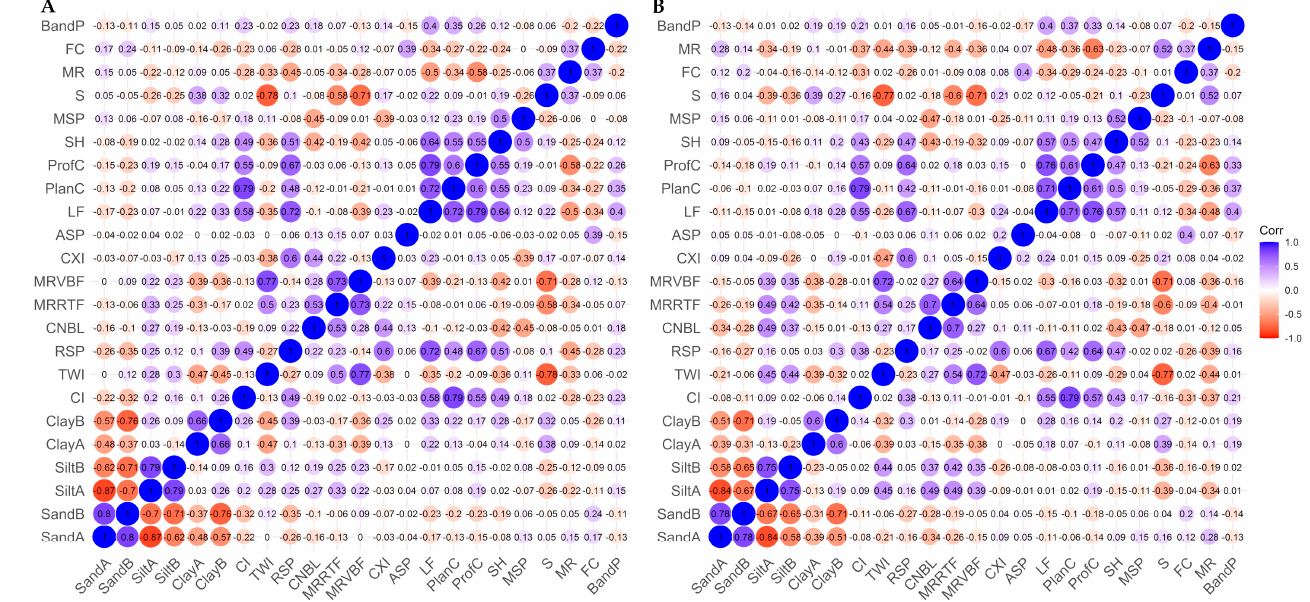
Figure 4. Correlation matrices of remote sensing covariates against soil particle size fractions in the training datasets from the reference area ( A ) and total area ( B ). ClayA, SiltA, SandA: surface soil particle sizes fractions; ClayB, SiltB, SandB: subsurface soil particle sizes fractions. A strong blue circle has a maximum positive correlation, a strong red circle has a maximum negative